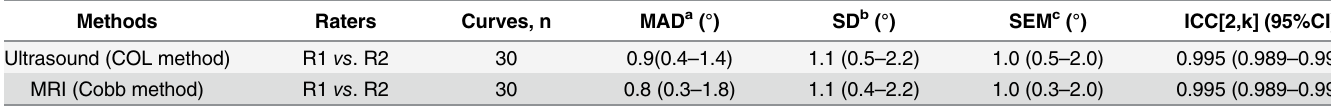
Table 2. Inter-rater variation and reliability of coronal curvature assessments using ultrasound compared with MRI. Methods